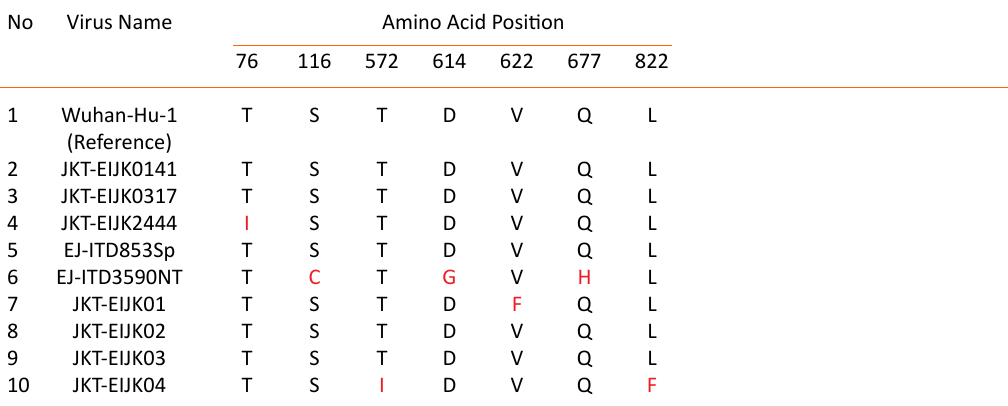
Table 3. Amino acid mutation sites in the SARS-CoV-2 spike glycoprotein